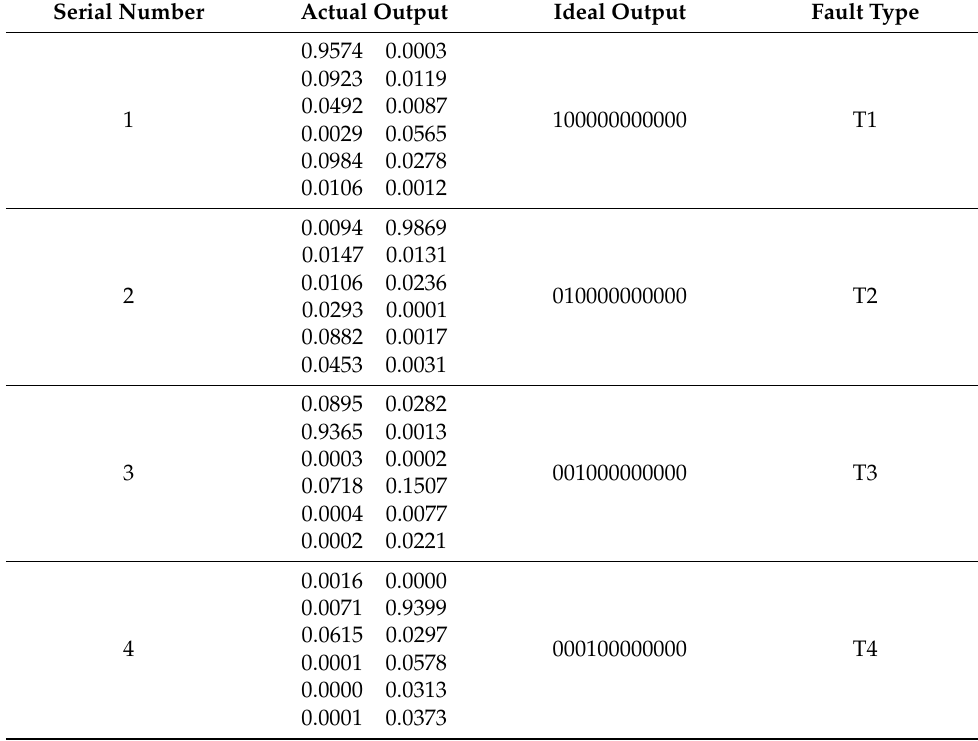
Table 2. Neural network diagnosis results.